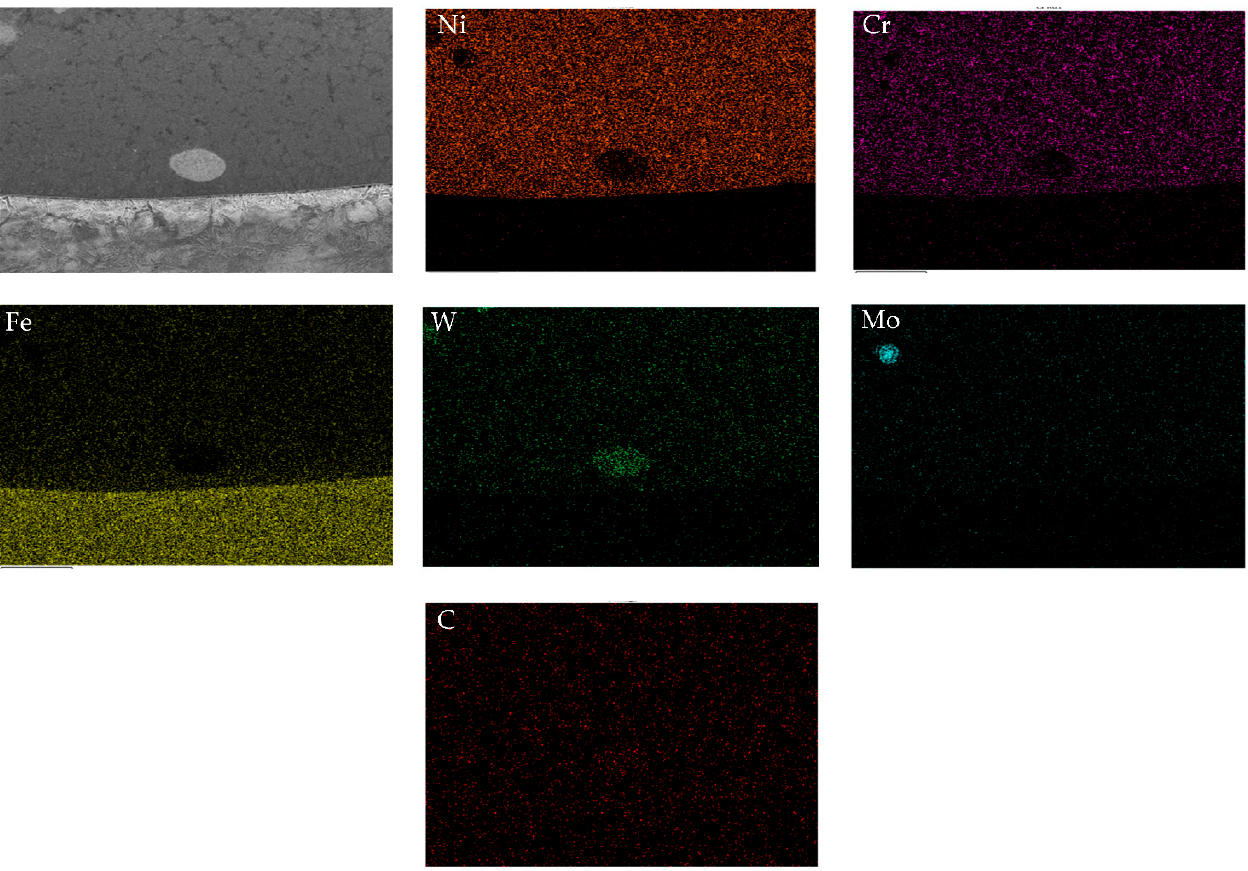
Figure 3. EDS of the 10 WC coating.